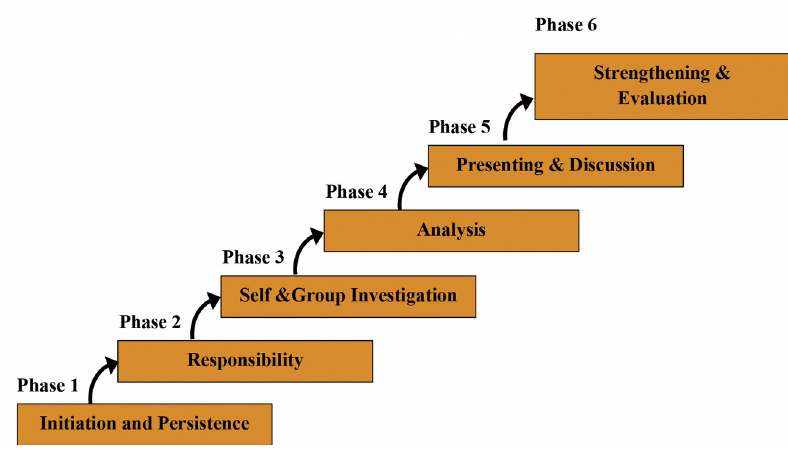
Figure 1. Model of Physics Independent Learning (MPIL) Phase